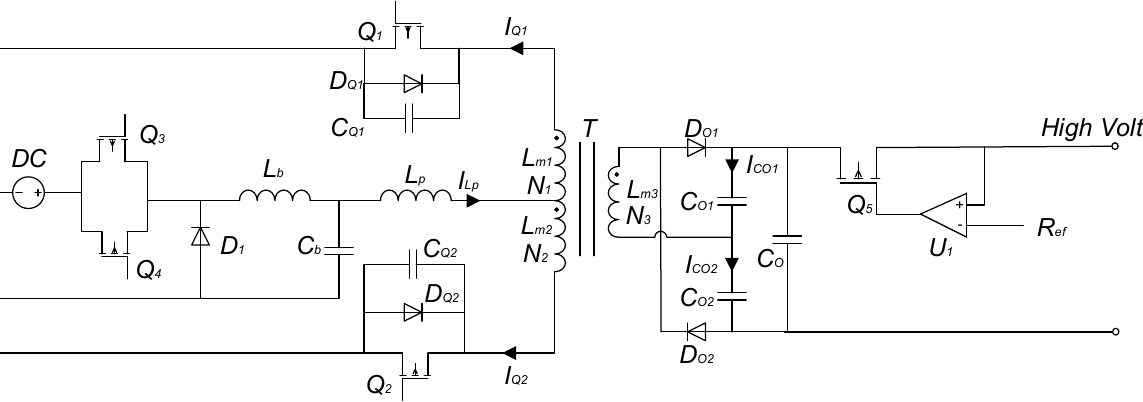
Figure 3. Topology of the four-stage DC/DC high − voltage converter.